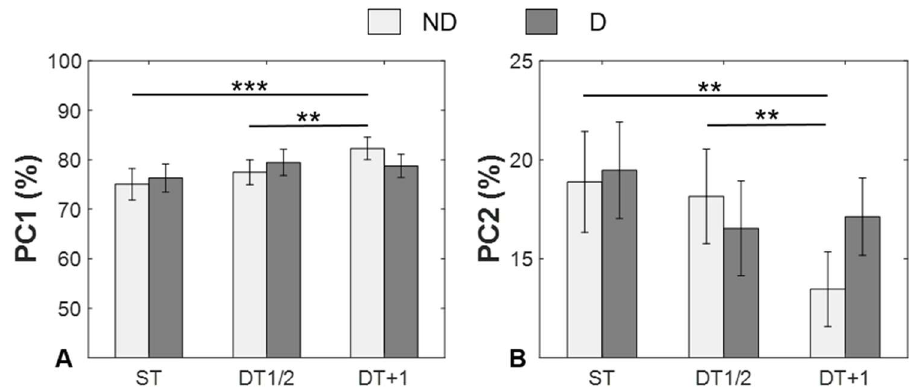
Figure 5. Comparison of variance explained by the first three principal components between ND and D limbs under different task conditions (ST, DT1/2, and DT + 1). Values are mean ± standard error. Significant post hoc comparisons (Holm–Bonferroni adjusted for multiple comparisons): ** p < 0.01. *** p < 0.001. There was a significant interaction effect between limb dominance and task condition in PC1 ( A ) and PC2 ( B ).